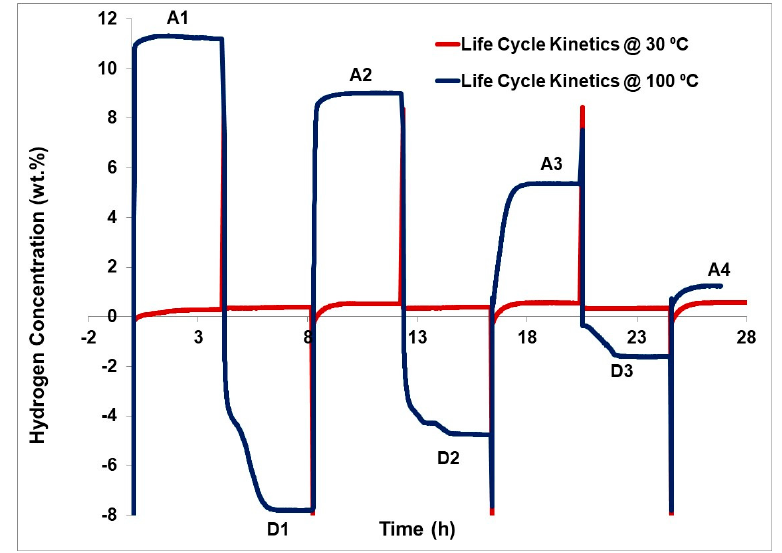
Figure 14. SEM images showing the surface morphology of electrospun polyaniline nanofibers.